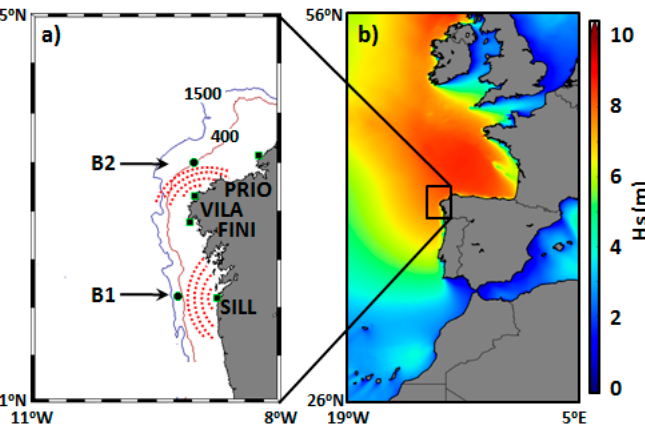
Figure 1. ( a ) General area of study and High-Frequency (HF) radar coverage area, where arcs are shown emerging concentrically from one radar site. Locations of the B1 and B2 buoys and four radar sites (SILL, FINI, VILA, and PRIO) are marked with filled dots and squares, respectively. Bathymetric contours show depths at 400 and 1500 m; ( b ) The daily averaged significant wave height (Hs) predicted in the Iberia–Biscay–Ireland (IBI) regional domain (24 February 2015).